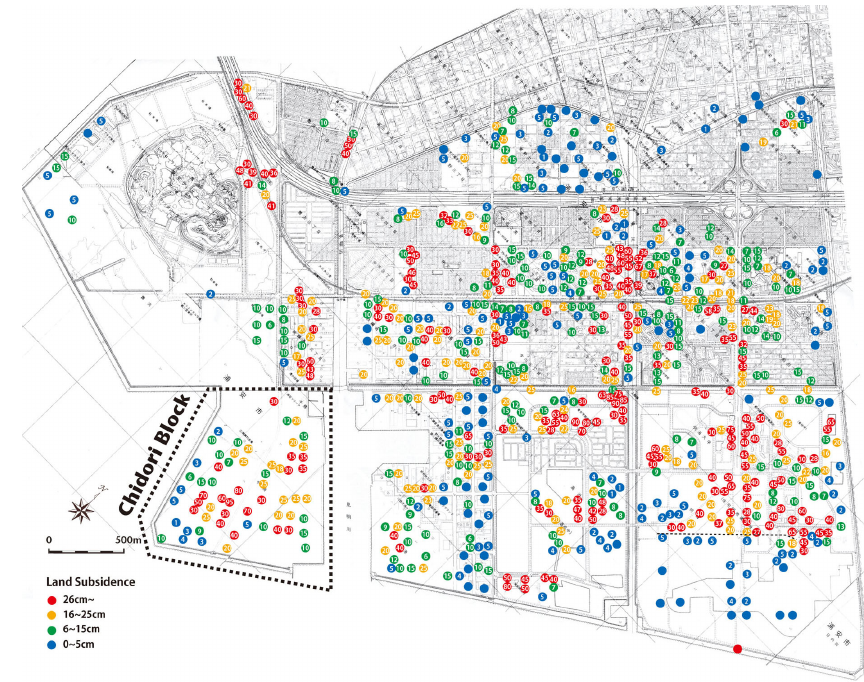
Figure 4. Values of land subsidence caused by the 2011 Tohoku earthquake in Urayasu City (RIEGC, 2011).